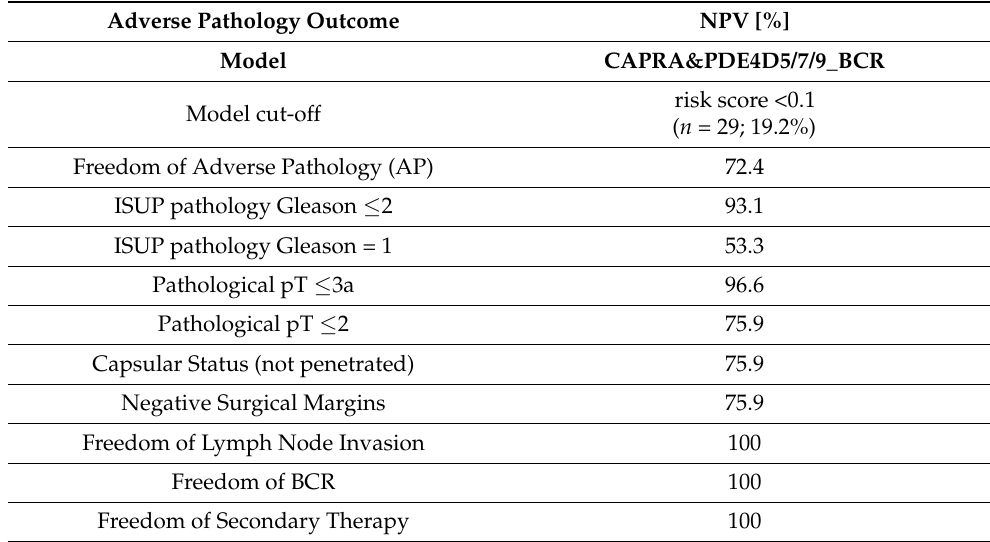
Table 6. Negative Predictive Value (NPV) of the CAPRA&PDE4D5/7/9_BCR model (entire cohort; n = 151). The cut-off 0.1 was selected for the CAPRA&PDE4D5/7/9_BCR regression model which separates the patients into a low-risk group ( n = 29) vs. an intermediate–high-risk group ( n = 122). B) Positive Predictive Value (NPV) of the CAPRA&PDE4D5/7/9_BCR model (entire cohort; n =151). The cut-off 0.835 separates the patients into a low–intermediate risk group ( n = 109) vs. a high-risk group ( n = 42). The tested endpoints are indicated. PSAD–PSA density (ng/ng/mL). Adverse Pathology is defined as any ISUP pathological Gleason grade >2, or pathological pT stage > pT3a, or tumor penetrated prostate capsular status, or pN1 disease. BCR–biochemical recurrence after surgery.